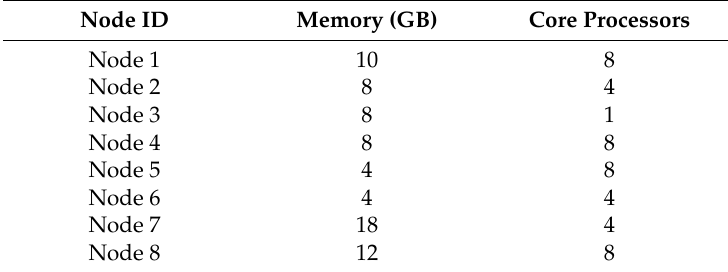
Table 1. The detailed information of each virtual machine.